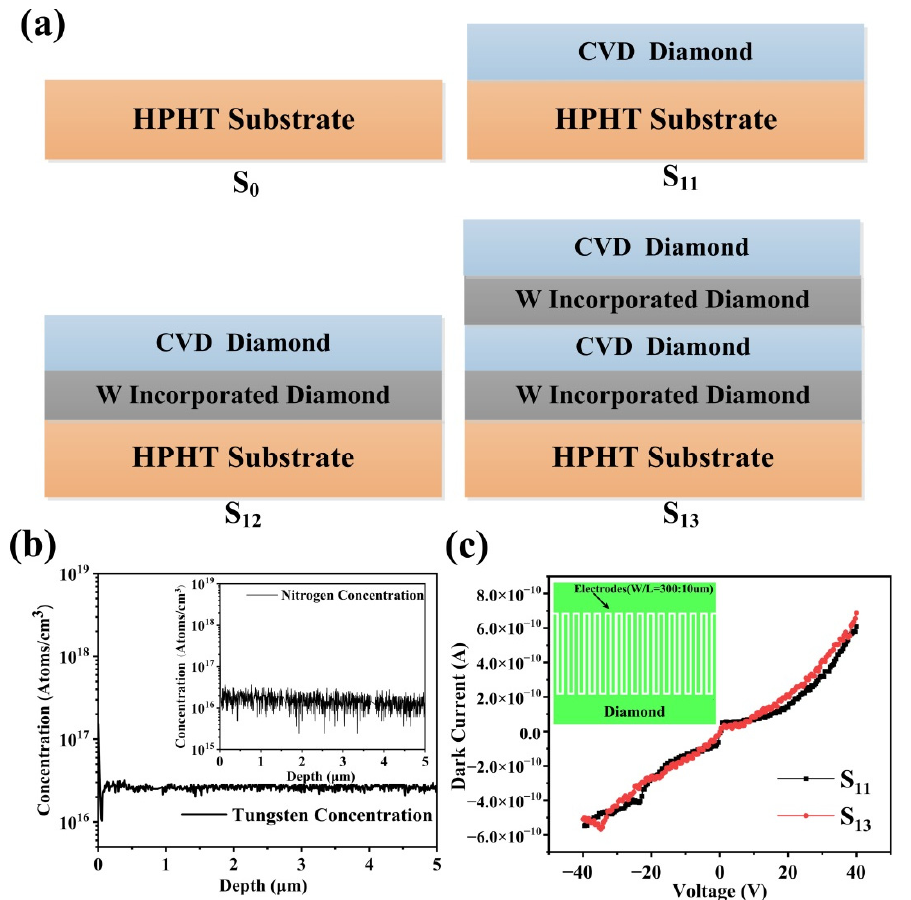
Figure 1. ( a ). Cross-section structures of substrate (S 0 ) and three other epitaxial diamond structures. (S 11 , S 12 , and S 13 ); ( b ). W concentration in tungsten-incorporated diamond tested by SIMS (inset is the nitrogen concentration). ( c ) I–V curves of S 11 and S 13 under dark condition.